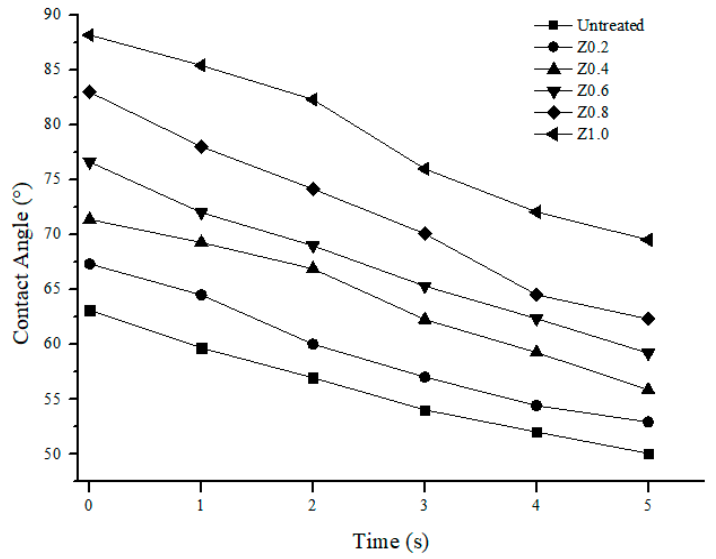
Figure 6. Water contact angle for untreated nylon 6,6 NFM and nylon 6,6/ZIF-8 NFM.